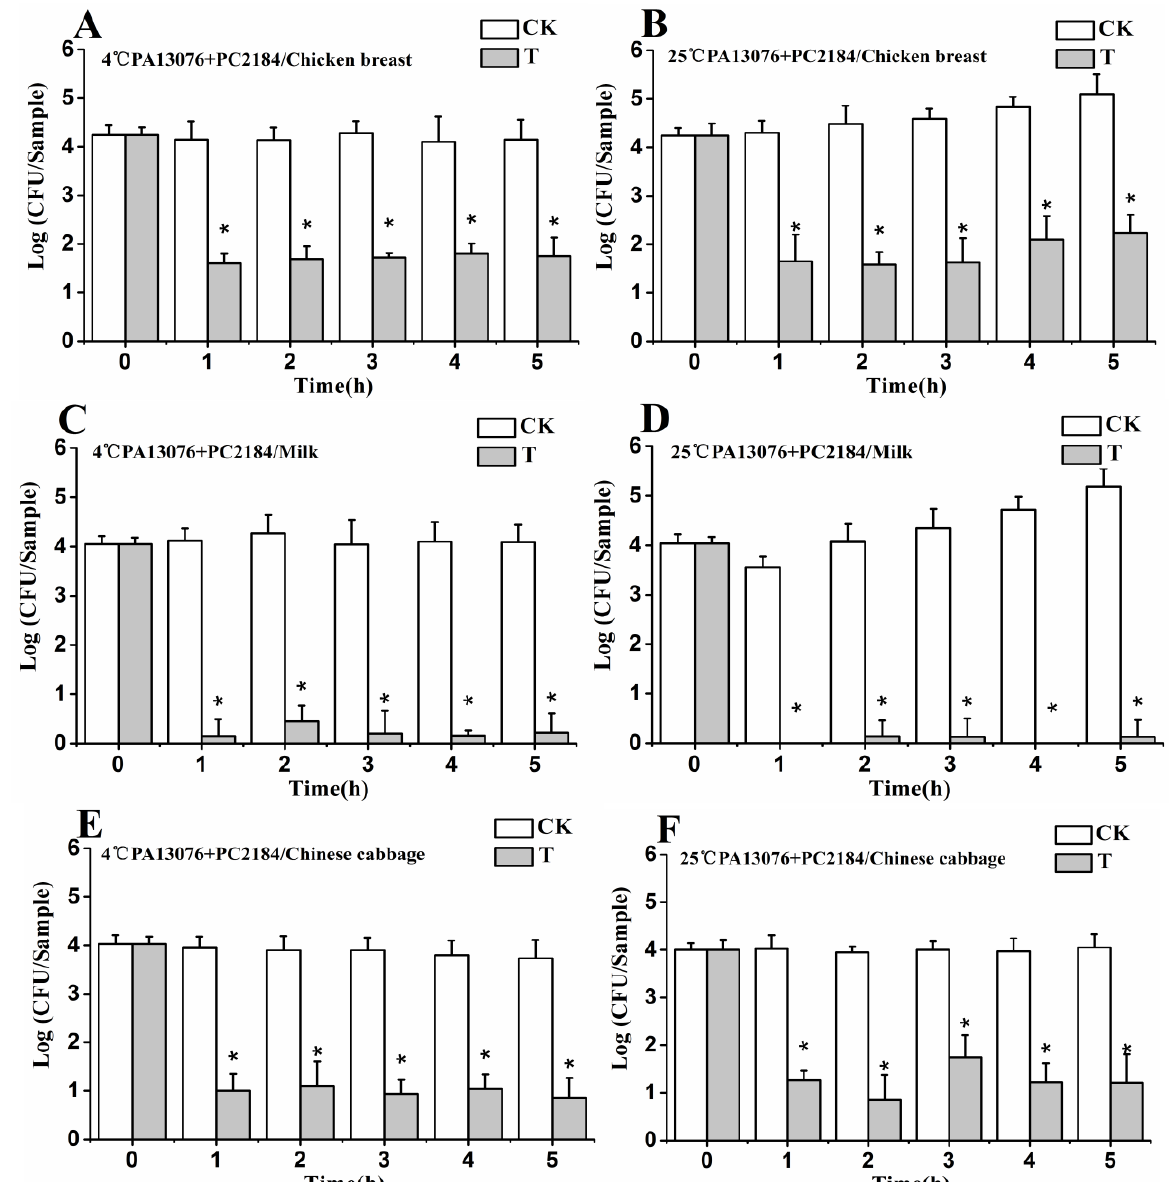
Figure 7. Efficacy of phage cocktail on reducing SE mixture treated food samples at 4